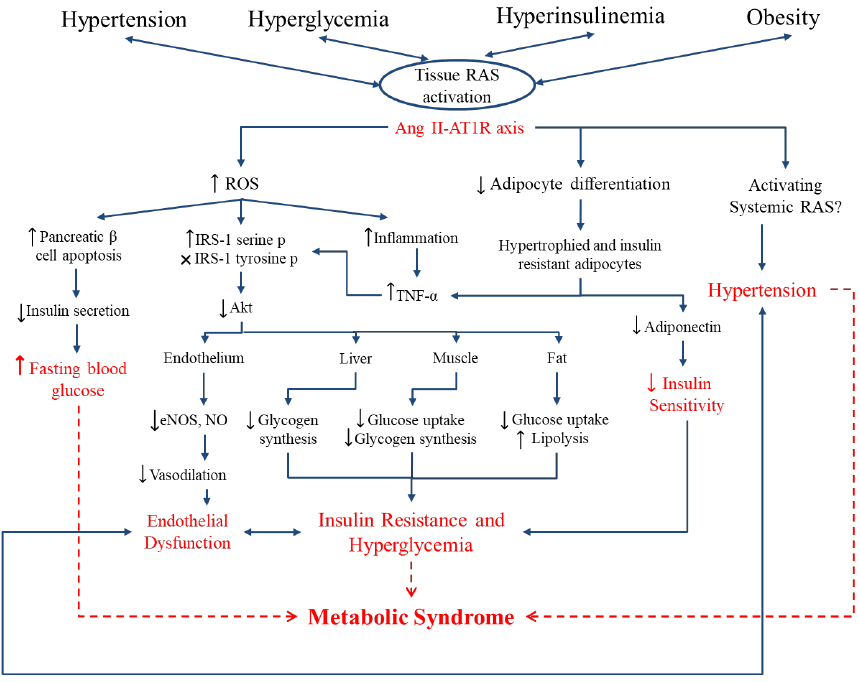
Figure 2. Link between the RAS, oxidative stress, and metabolic syndrome. Hyperglycemia, hypertension, hyperinsulinemia and obesity enhance the expression of local RAS components, especially the Ang II-AT1R axis, in specific tissues. Ang II retards adipocyte di ff erentiation, leading to adipocyte dysfunction and reduced insulin sensitivity through reduced adiponectin secretion and enhanced pro-inflammatory adipokines. Ang II further enhances reactive oxygen species (ROS) production, a ff ecting several pathways in di ff erent tissues in the body. Enhanced inflammation, disturbed insulin signaling in endothelium, liver, muscle and adipose tissue leads to endothelial dysfunction and insulin resistance. Furthermore, oxidative stress damages pancreatic β -cells that diminishes insulin secretion and enhances fasting blood glucose. Overall, local RAS overproduction contributes to the enhanced fasting blood glucose, endothelial dysfunction, systemic insulin resistance, and hyperglycemia the hallmarks of metabolic syndrome. Figure is drawn based on